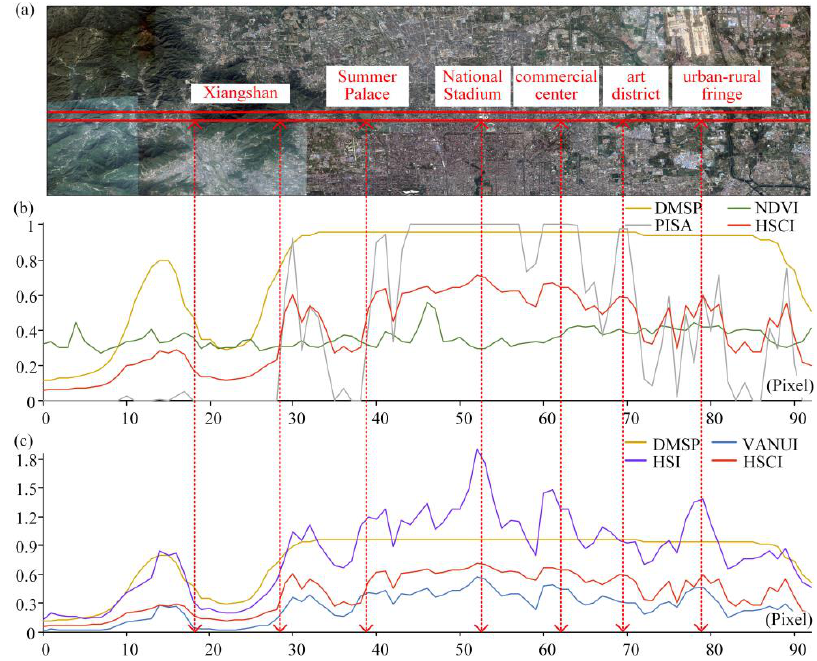
Figure 5. ( a ) Google Earth image covering part of Beijing, ( b ) Longitudinal profiles of DMSP (normalized), NDVI, PISA, and HSCI signals; ( c ) Longitudinal profiles of DMSP (normalized), VANUI, human settlement index (HSI), and HSCI values.